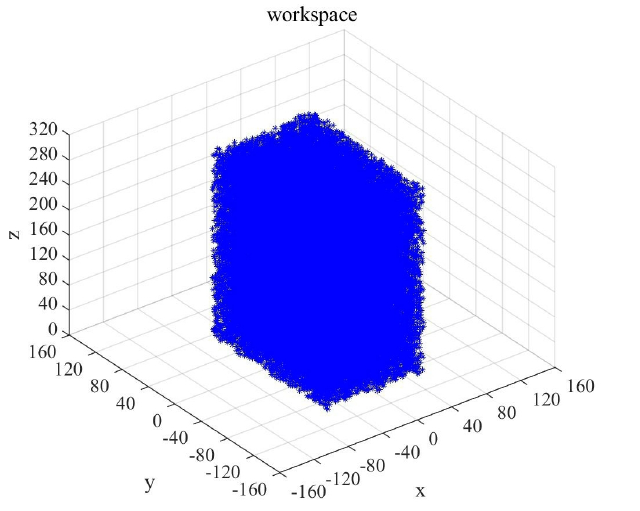
Figure 18. Fixed posture